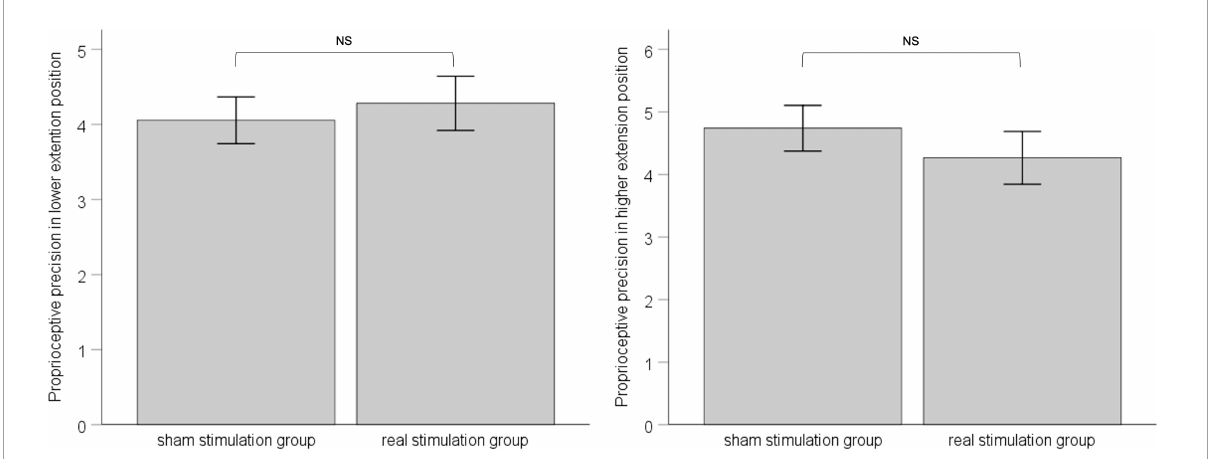
FIGURE5 The left panel shows post-stimulation performance of proprioceptive precision in the lower-extension position; the right panel shows post-stimulation performance of proprioceptive precision in the higher-extension position. Error bars indicate Standard Error. NS indicates no statistical